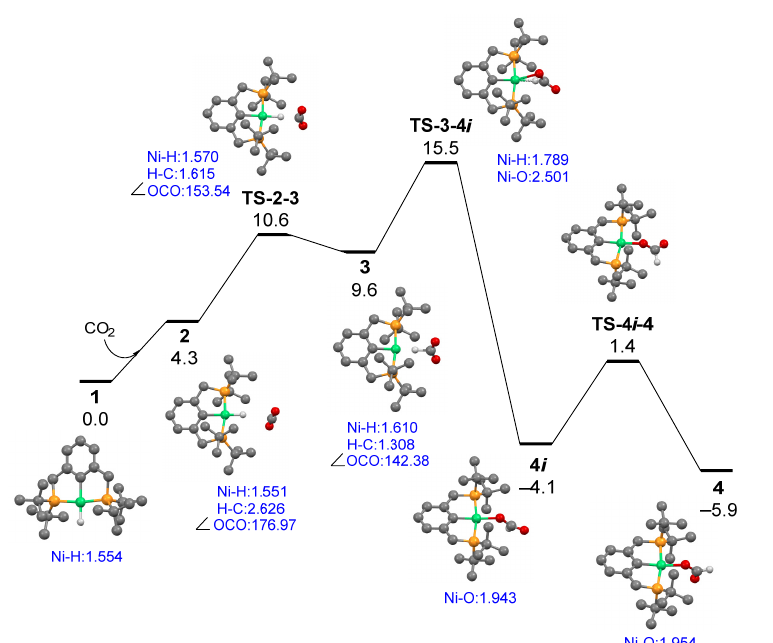
Figure 3. Free energy diagram for CO 2 insertion into I , tBu2 (PCP)Ni–H. Selected atom distances are given in Å, selected bond angles are given in degrees, and Δ G°/ Δ G ‡ are in kcal mol –1 . Hydrogen atoms except the hydride are omitted for clarity. Color code: green, Ni; yellow, P; gray, C; red, O; white, H.